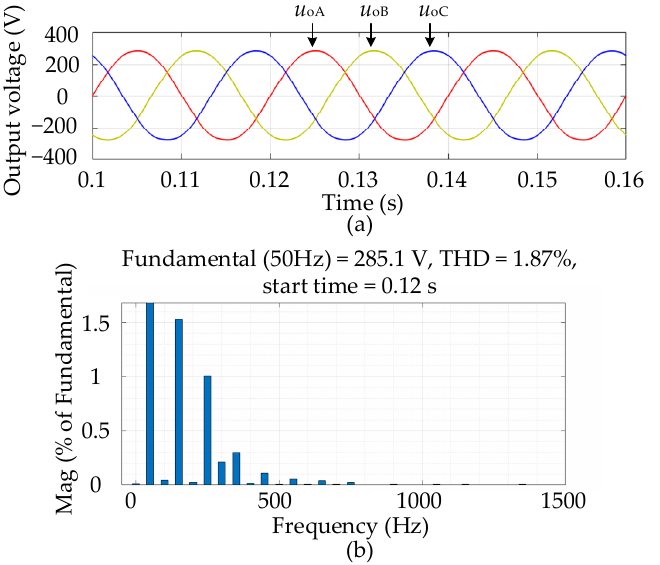
Figure 8. ( a ) The output voltage of each phase under the resistive–inductive load condition. ( b ) The FFT result of the A-phase output voltage.